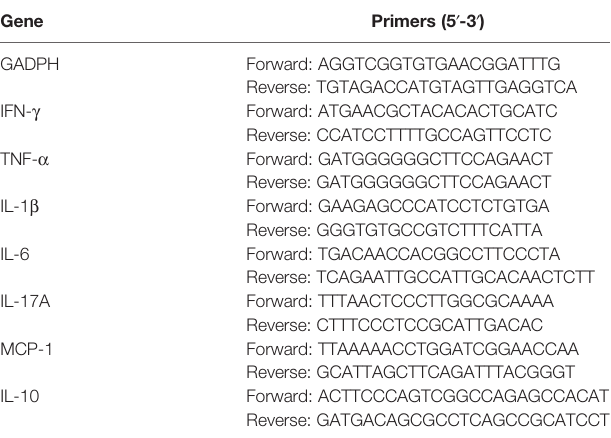
TABLE 1 | The primer sequences used for real-time